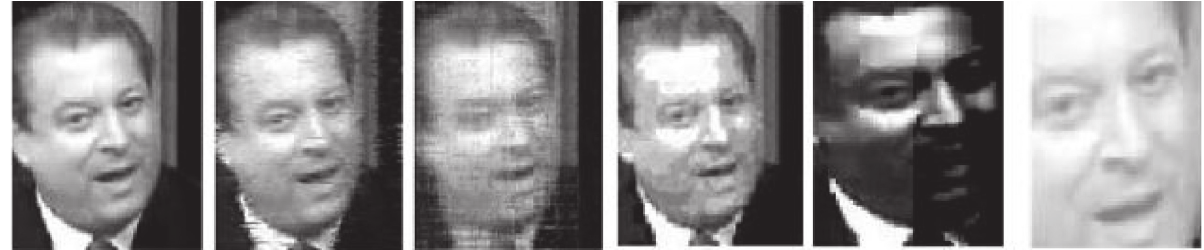
Figure 4: 1 st column, corrupted video face image; 2 nd column, the low-rank component by [31]; 3 rd column, the low-rank component by [30]; 4 th column, the low-rank component by [38]; 5 th column, the low-rank component by [39]; 6 th column, the low-rank component by the proposed method.